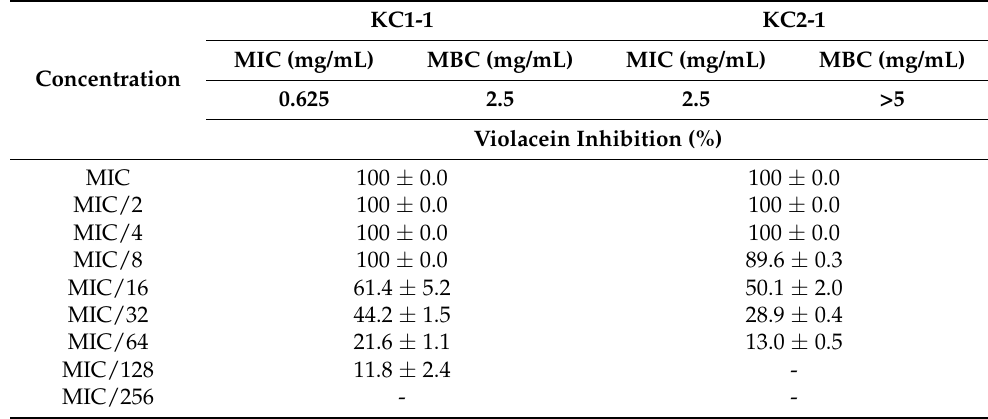
Table 3. Inhibition of violacein formation (%) using C. violaceum CV12472.